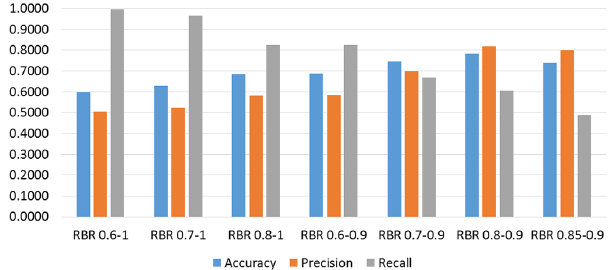
Figure 4. Cloud detection accuracy using various RBR